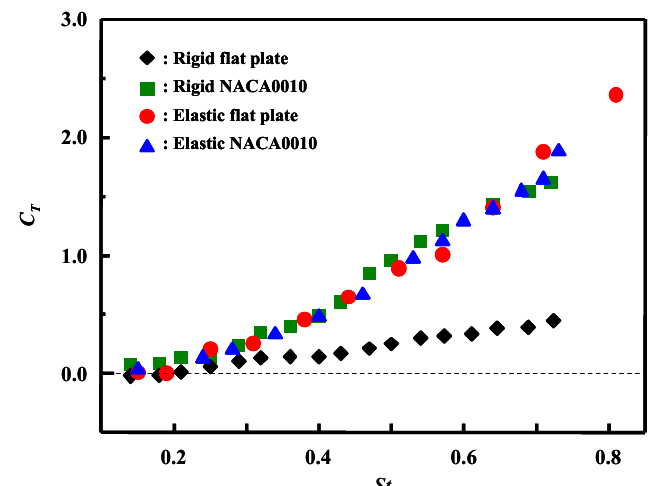
Fig. 8 Mean values of dynamic thrust acting on the heaving airfoils for one heaving